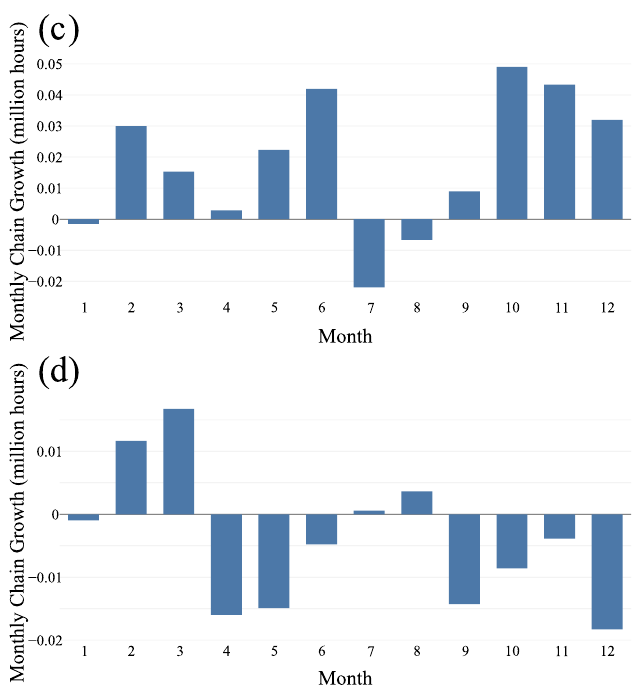
Figure 14. Monthly chain growth from 2017 to 2020 in some countries: ( a ) China; ( b ) Spain; ( c ) United States; and ( d ) Japan.